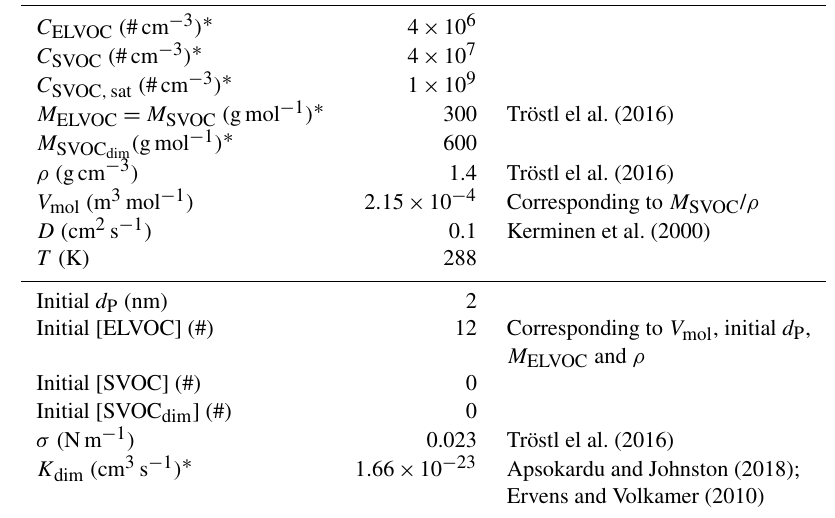
Table 1. Values of the variables in the model runs for the base case run. Variables marked with asterisk ( ∗ ) are varied in the sensitivity analysis. The variables mainly related to the atmospheric conditions and vapours are shown in the upper part and those related to the growing particle in the lower part of the